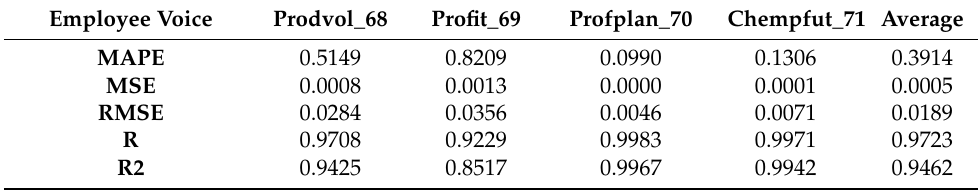
Table 10. Testing results for the effect of employee voice on firm performance.